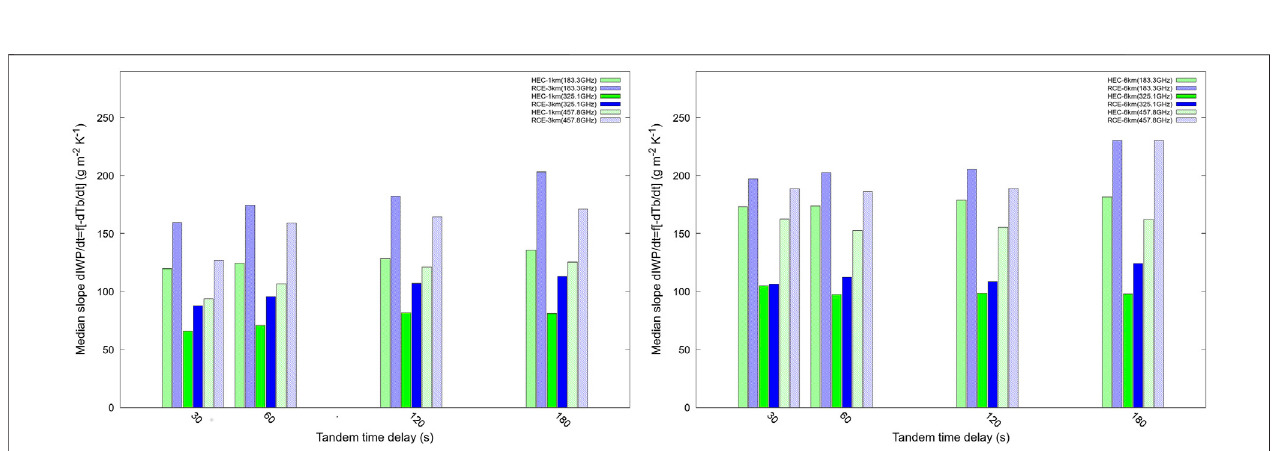
FIGURE 9 | Slope of dIWP/dt as a function of dTb/dt for the 183.3, 325.1, and 457.8 GHz channels at the horizontal resolution of the simulations (left) and at a linearly interpolated 6-km pixel resolution (right). The time delay of the satellite tandem ranges from 30 s to 3 min. Results are shown for grid points verifying the deep convection